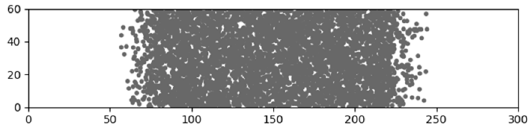
Figure 9. The fracture locations of 5000 numerical repetitions.